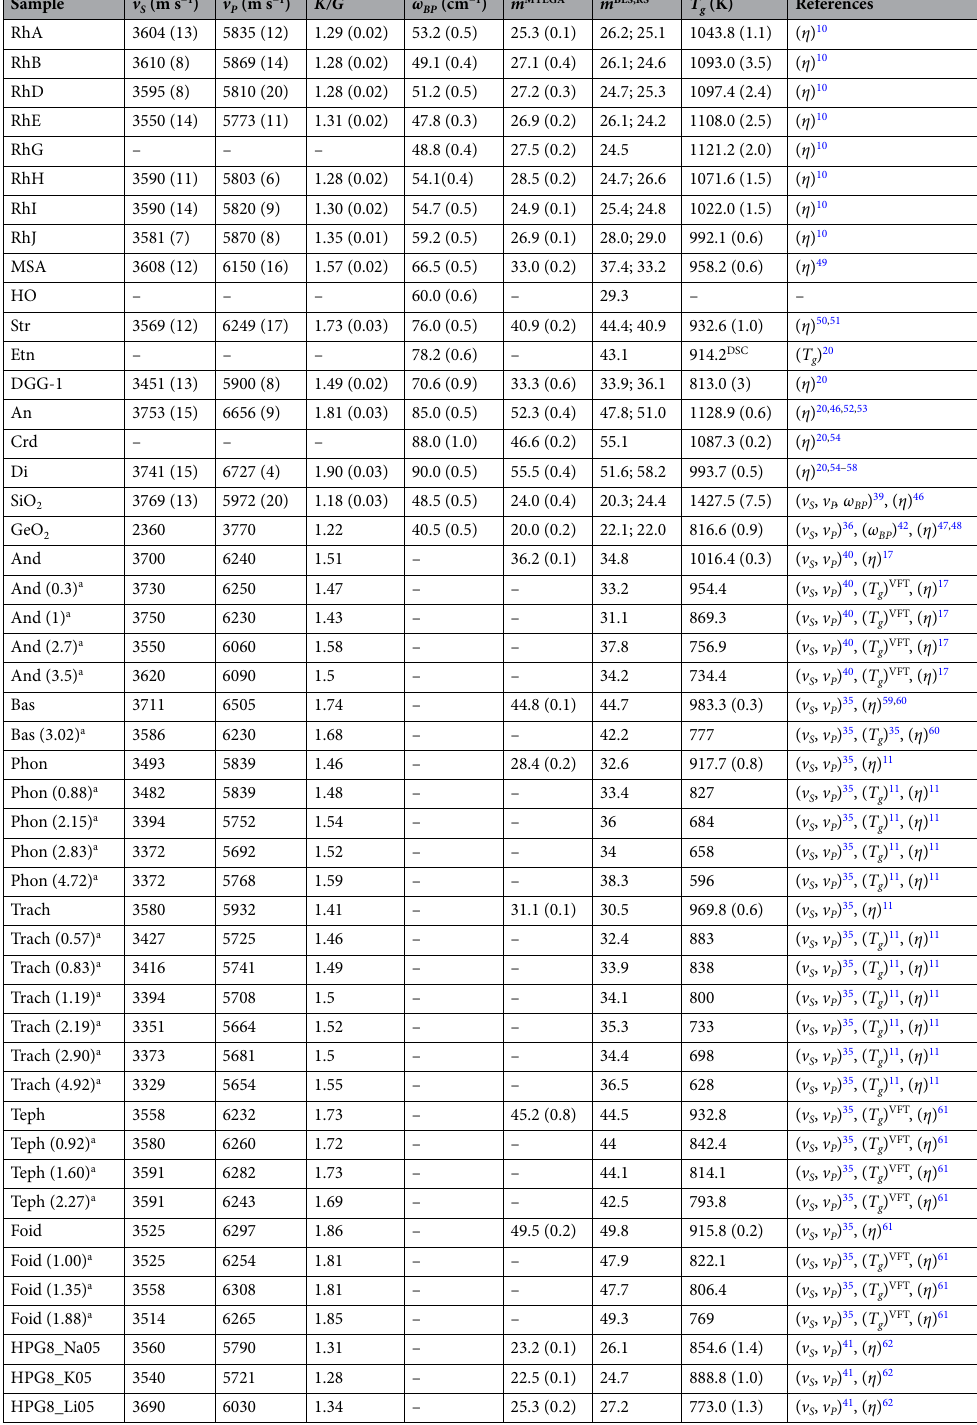
Table 2. Brillouin and Raman data, as well as MYEGA parameters ( m and T g ) from this study and the literature. Acoustic wave velocities ( v s and v p ), elastic moduli ratios ( K/G , Eq. 3) and boson peak positions ( ω BP ). The Brillouin and Raman spectroscopic measurements are from this study for samples RhA to Di. m BLS is calculated using the Brillouin data ( K/G ) and Eq. (6); m RS is calculated using the Raman data ( ω BP ) and Eq. (7); m MYEGA and T g (unless specified in the References column) are derived using Eq. (1) and viscosity data 2.93 from the literature (assuming η ∞ = 10 − Pa s); T g VFT is the calculated glass transition temperature using VFT parameters provided by the literature; DSC is the glass transition temperature derived via DSC in Ref. 20 for Etn; a H 2 O content in wt%. External samples used for validation (Figs. 4, 6) are RhB, And (hydrous), Bas (hydrous), Teph (dry and hydrous), Trach (dry and hydrous), Phon (hydrous), Foid (hydrous) and HPFS 7980 fused silica 63 for the BLS approach, and RhB, MSA and Str (all anhydrous) for the RS